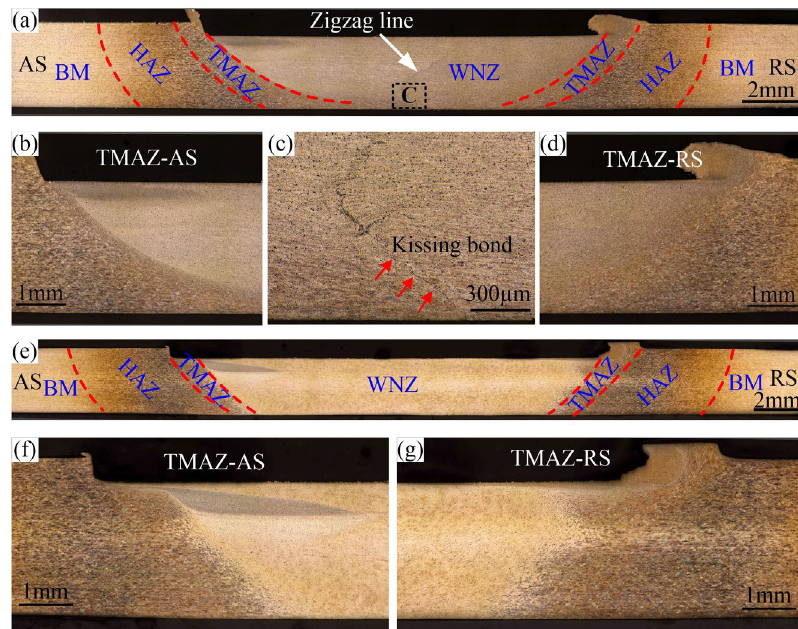
Figure 7. Characteristics of the weld transverse cross-section: ( a ) d = 12 mm; ( b – d ) the corresponding magnified pictures of TMAZ-AS, featured region C , and TMAZ-RS in ( a ); ( e ) d = 16 mm; ( f , g ) the corresponding magnified pictures of TMAZ-AS and TMAZ-RS in ( e ); ( ω = 600 rpm, v = 30 mm/min).